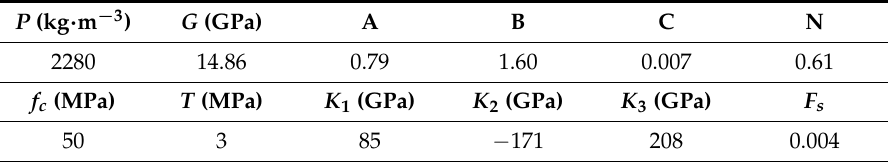
Table 2. Holmquist-Johnson-Cook (HJC) model parameters of